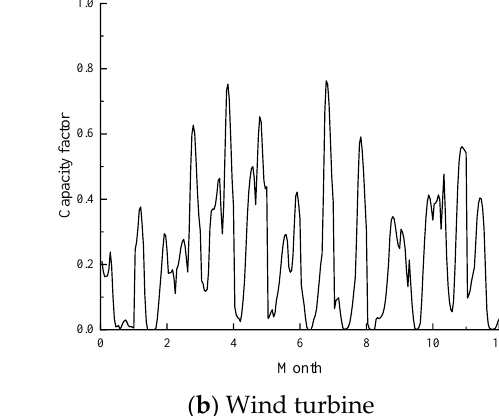
Figure 2. Capacity factors of the photovoltaic panel and the wind turbine.